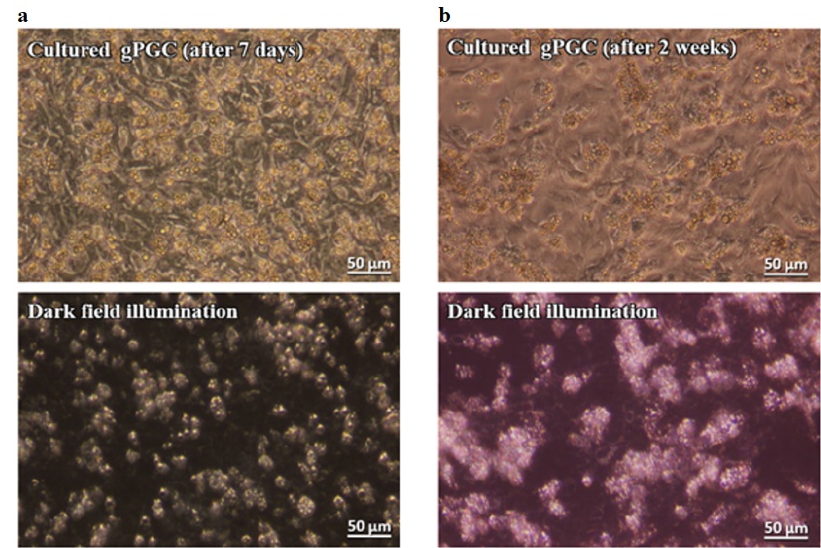
Figure 2. The gPGCs cultured for 7 and 14 days, observed under an inverted phase-contrast microscope and in darkfield illumination. This technique allows us to clearly distinguish PGCs from the feeder layer and other cells. The PGCs are visible as bright, illuminated cells among the other cell types (P.434242 patent application number). Magnification with 40× objective (Leica DMI8).